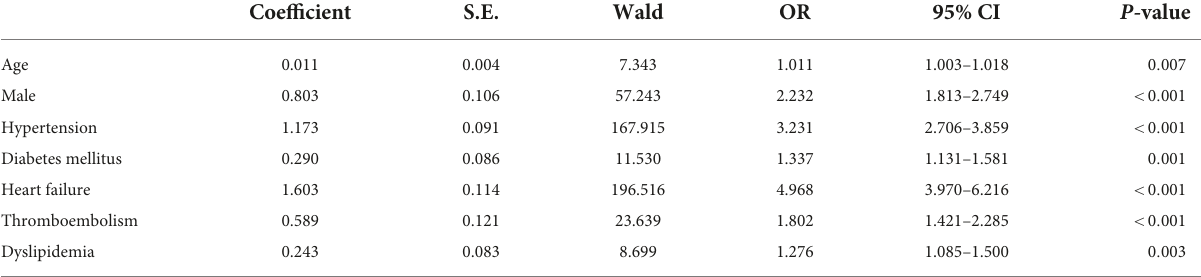
TABLE 2 Multivariate regression analysis investigating independent predictors of recurrent myocardial